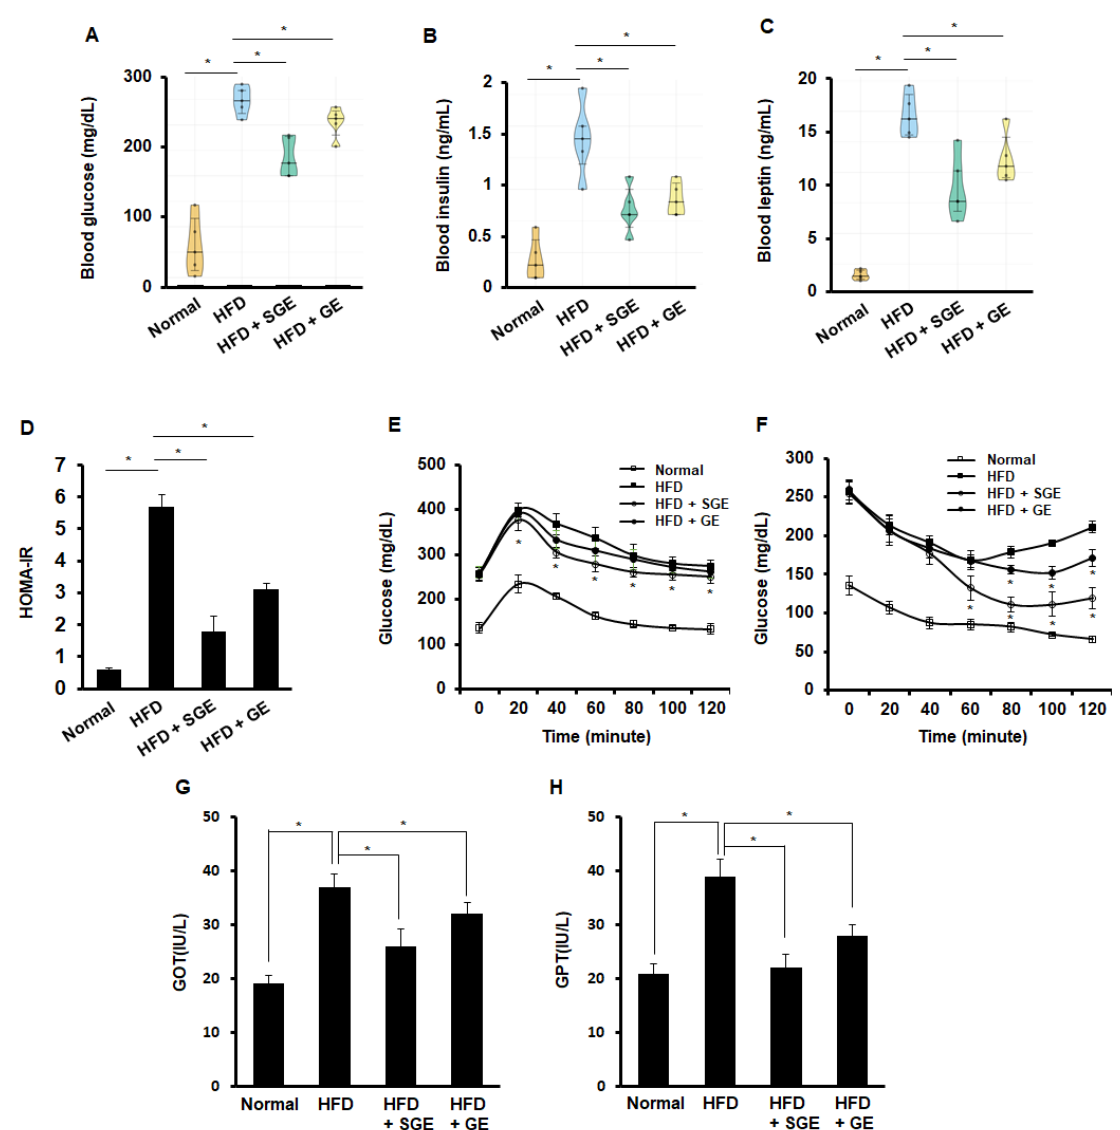
Figure 2. Korean red ginseng inhibits HFD-induced diabetic characteristics. ( A – C ) After fasting for 4 h prior to the end of the experiments, blood samples were collected ( n = 5/group). ( A ) Blood glucose level, ( B ) blood insulin level, ( C ) blood leptin level, ( D ) homeostasis model of assessment-insulin resistance (HOMA-IR), ( E ) intraperitoneal glucose tolerance test, ( F ) intraperitoneal insulin tolerance test, ( G ) levels of glutamic oxaloacetic transaminase (GOT) activity, and ( H ) levels of glutamic pyruvic transaminase (GPT) activity. *, p <